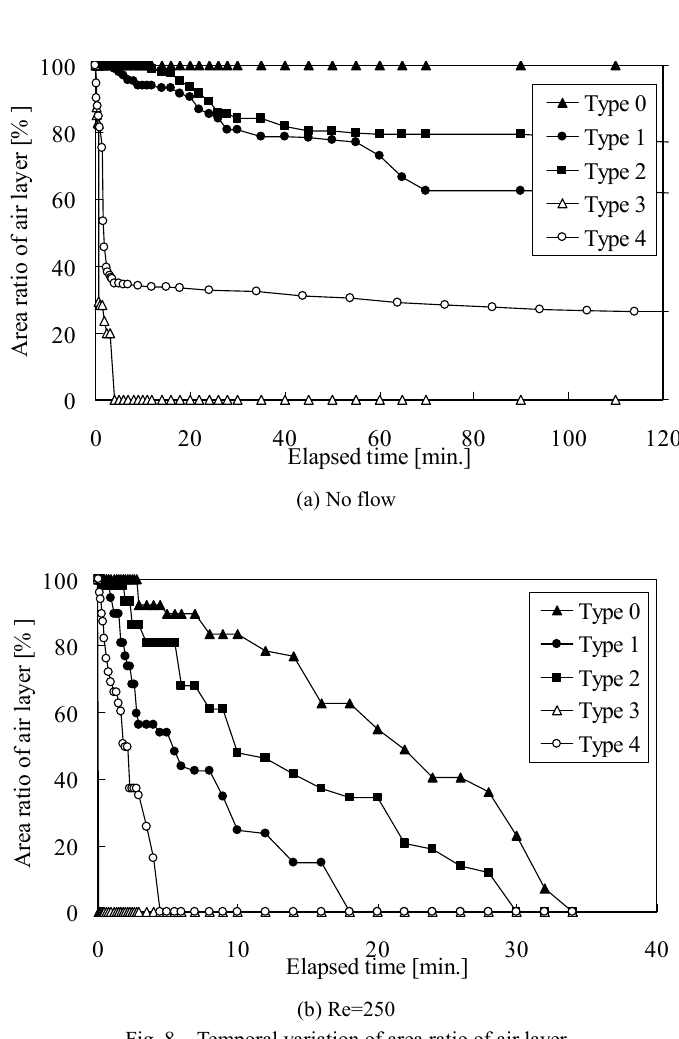
Fig. 8 Temporal variation of area ratio of air